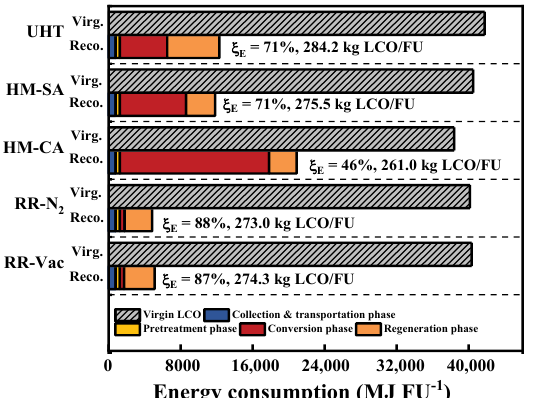
Figure 5. Contribution analysis of the total energy consumption for the five different methods. Each pair of bars represents a method, where the bottom bar represents the energy consumption distribution of each phase for 1 FU, the top bar is the energy consumption for producing an equivalent weight virgin LCO in industry, and the numbers indicate the reduction rate of energy consumption and recovered LCO from 1 FU for each method.